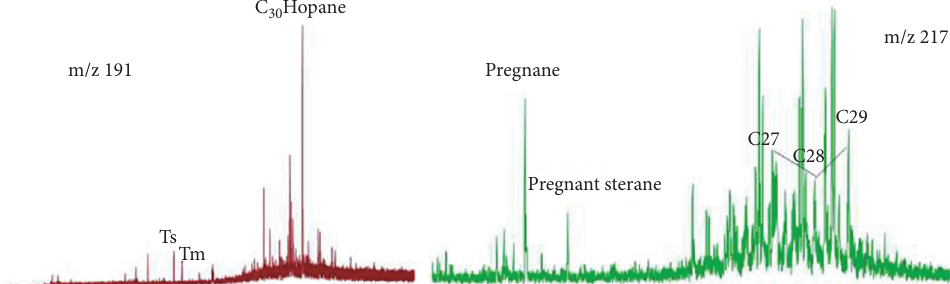
Figure 5: Mass spectrum of Chang 8 saturated hydrocarbons in well